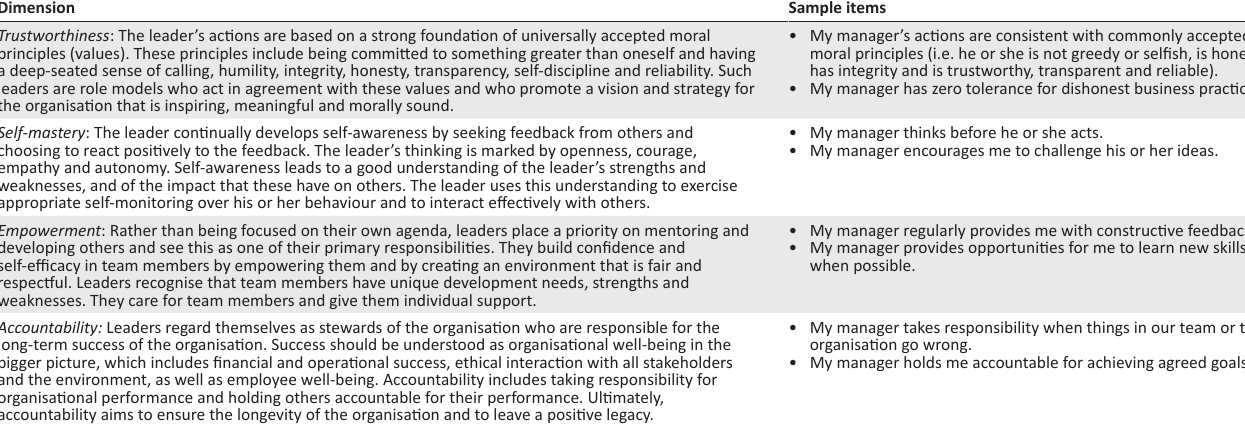
TABLE 1: Dimensions of the principled leadership scale and item samples. Dimension Sample